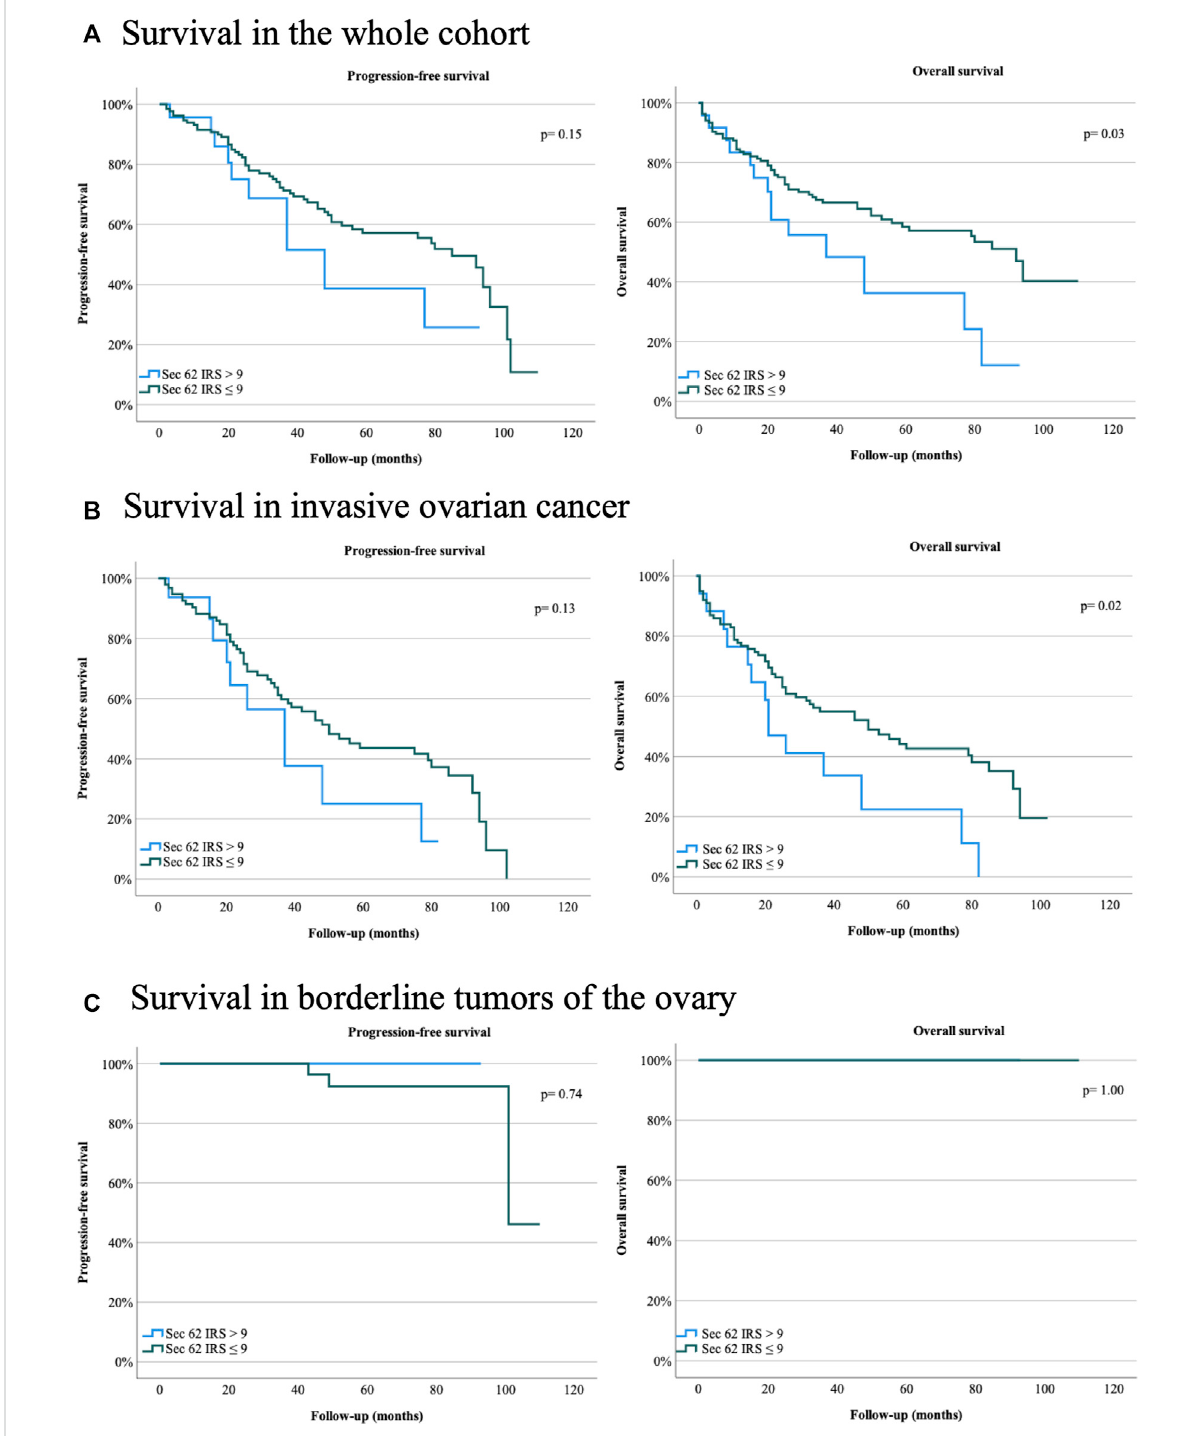
FIGURE 3 Survival rates for ovarian cancer patients and patients with borderline tumors of the ovary of the Department of Gynecology and Obstetrics, Saarland University Hospital, Homburg, Germany, between January 2007 and April 2019. (A) Progression-free and overall survival in the